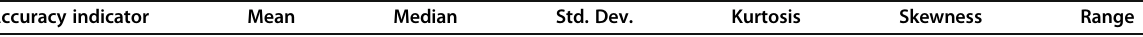
Table 5 Summary statistics of 9203 sample values of CWL10/CWL3 and CWL10_V/CWL3_V Accuracy